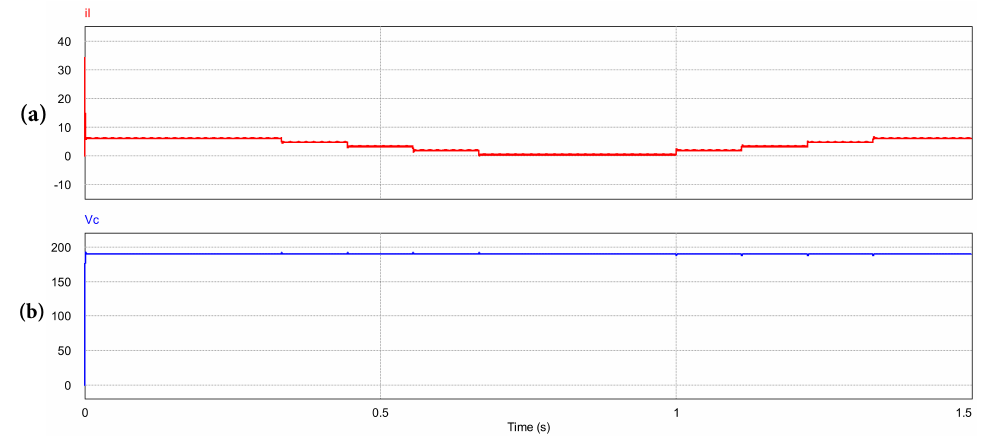
Figure 18. DC-DC full bridge converter 1.2 kW at 190 V with state feedback controller. ( a ) inductor current, ( b ) output voltage.